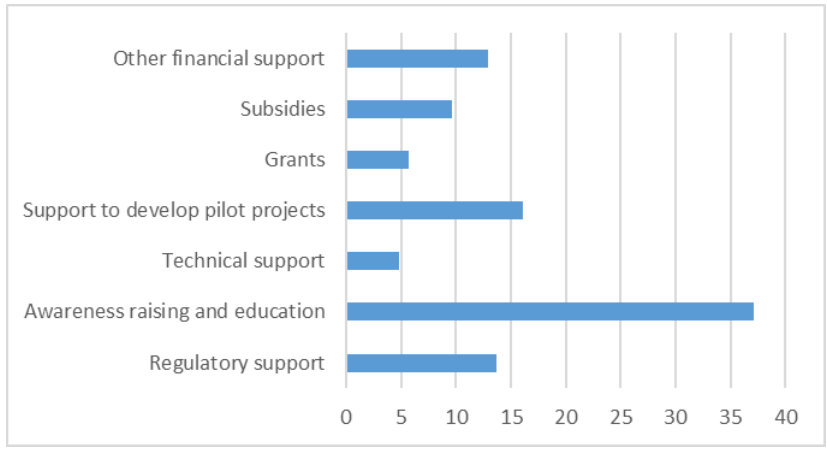
Figure 5. Perceived factors influencing the formation of CREIs (in percentages).